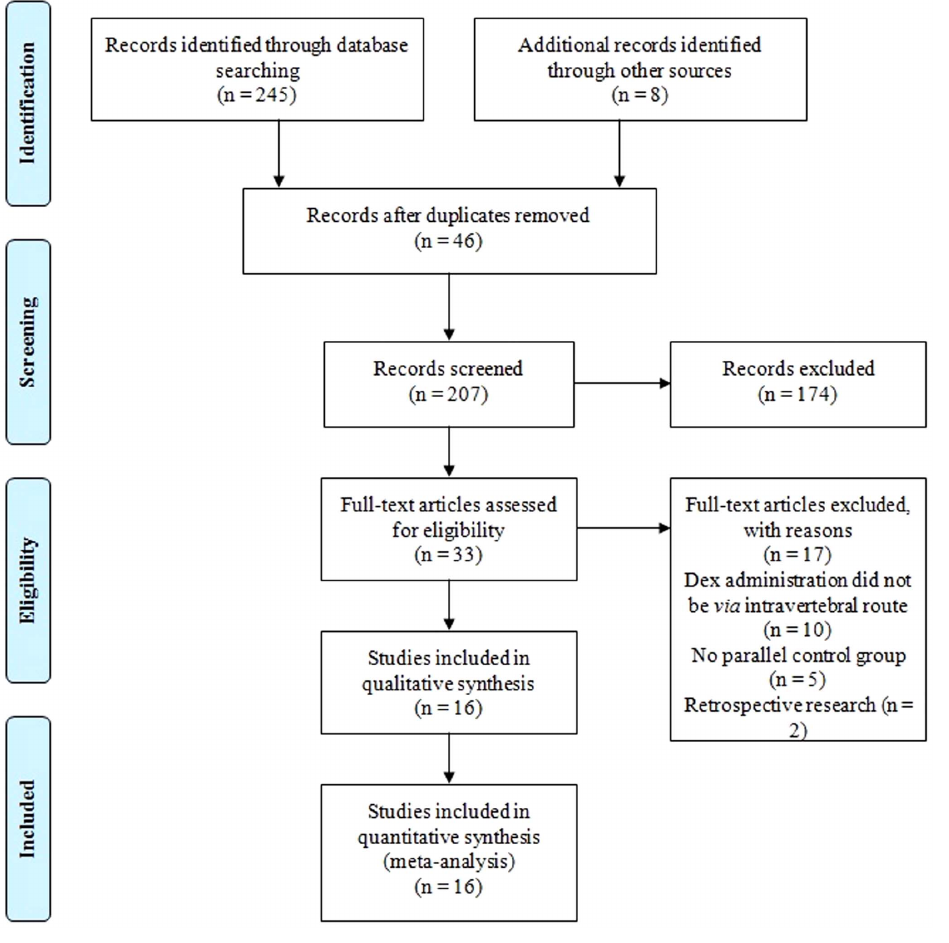
Figure 1. PRISMA flow diagram of search strategy and study selection.